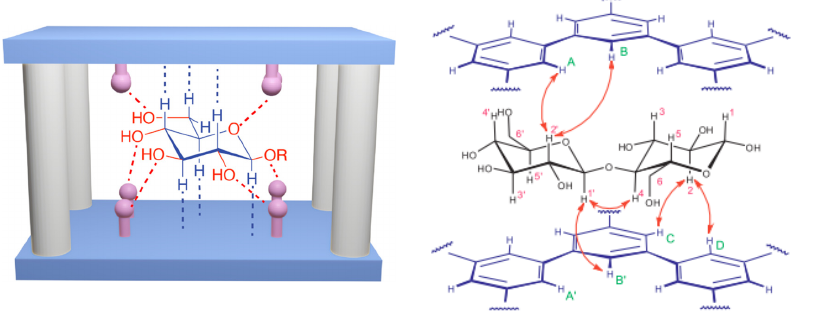
Figure 10. ( Left ) Temple receptor scheme for the glucose binding with C-H · · · π , C-H · · · O and N- H · · · O non-covalent interactions. The red dashed lines represent the polar interactions and the blue ones the hydrophobic interactions. ( Right ) Roof and floor components of the temple type receptor for the D-Cellobiose disaccharide. The left figure was reprinted with permission from [115]. Copyright (2021) American Chemical Society. The right figure was taken from reference [114], and reprinted with permission from